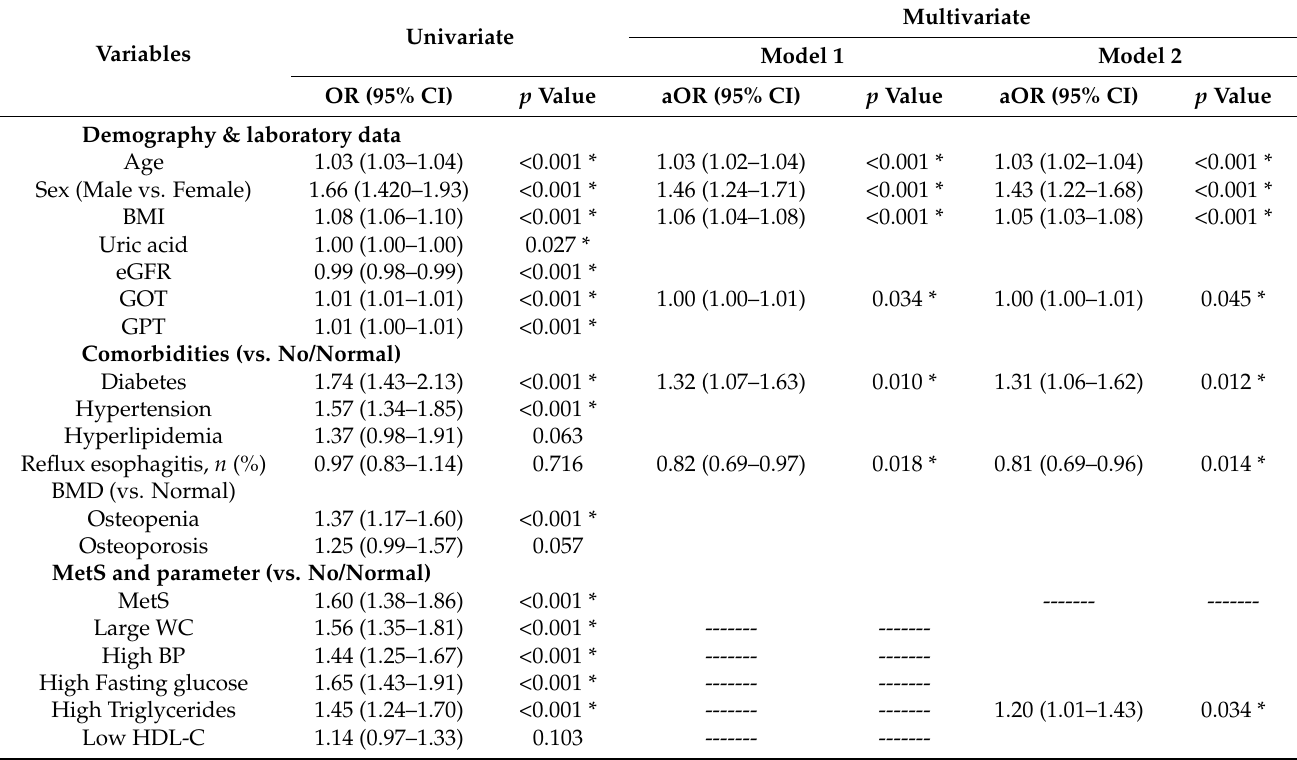
Table 3. Risk factors for gastric ulcer